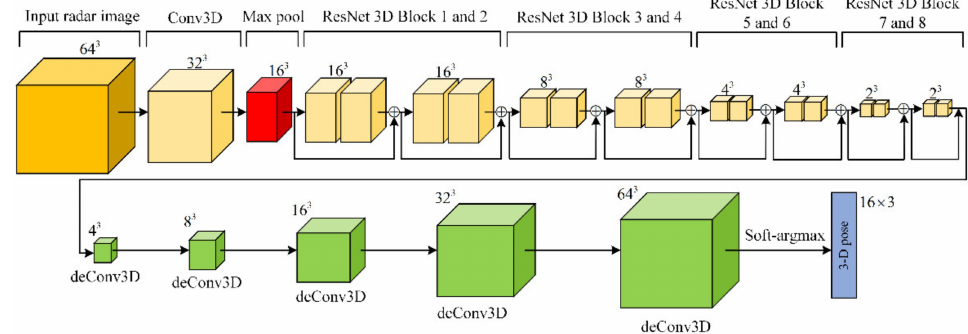
Figure 7. Pose reconstruction three-dimensional (3D) CNN network